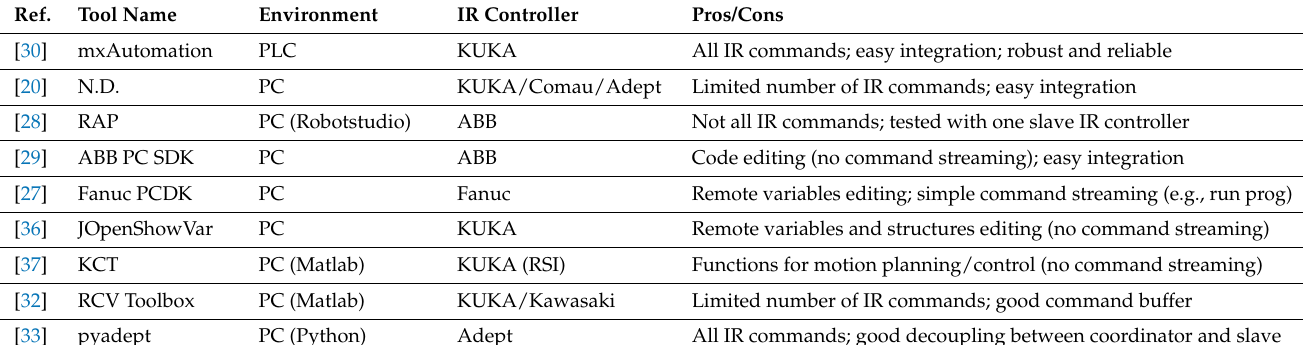
Table 2. Examples of external coordinators from